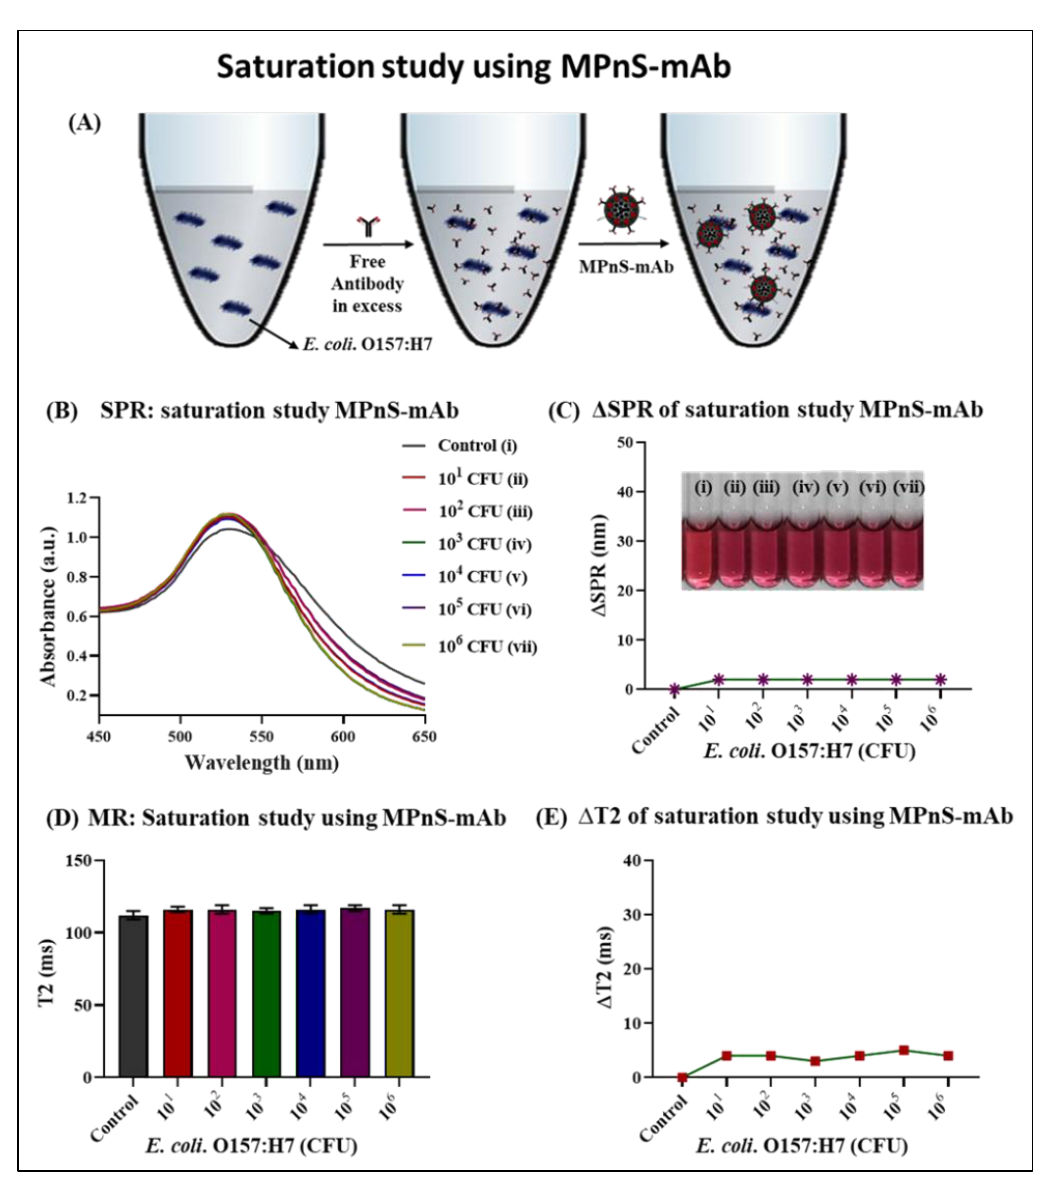
Figure 4. Saturation assay for functional MPnS-mAb: ( A ) Schematic diagram of the assay principle where excess of free anti - E. coli O157:H7 (10 µM) was incubated with increasing CFUs followed by addition of MPnS-mAb conjugated with anti - E. coli O157:H7. ( B ) Representative UV-Vis spectra showing no indication of binding or detection, and therefore, ( C ) no changes in absorption maxima ( Δ SPR) and color. ( D ) As expected, no sign of binding was observed in T2 MR experiments, and ( E ) displays little to no changes in ΔT2 MR values, further verifying specificity.